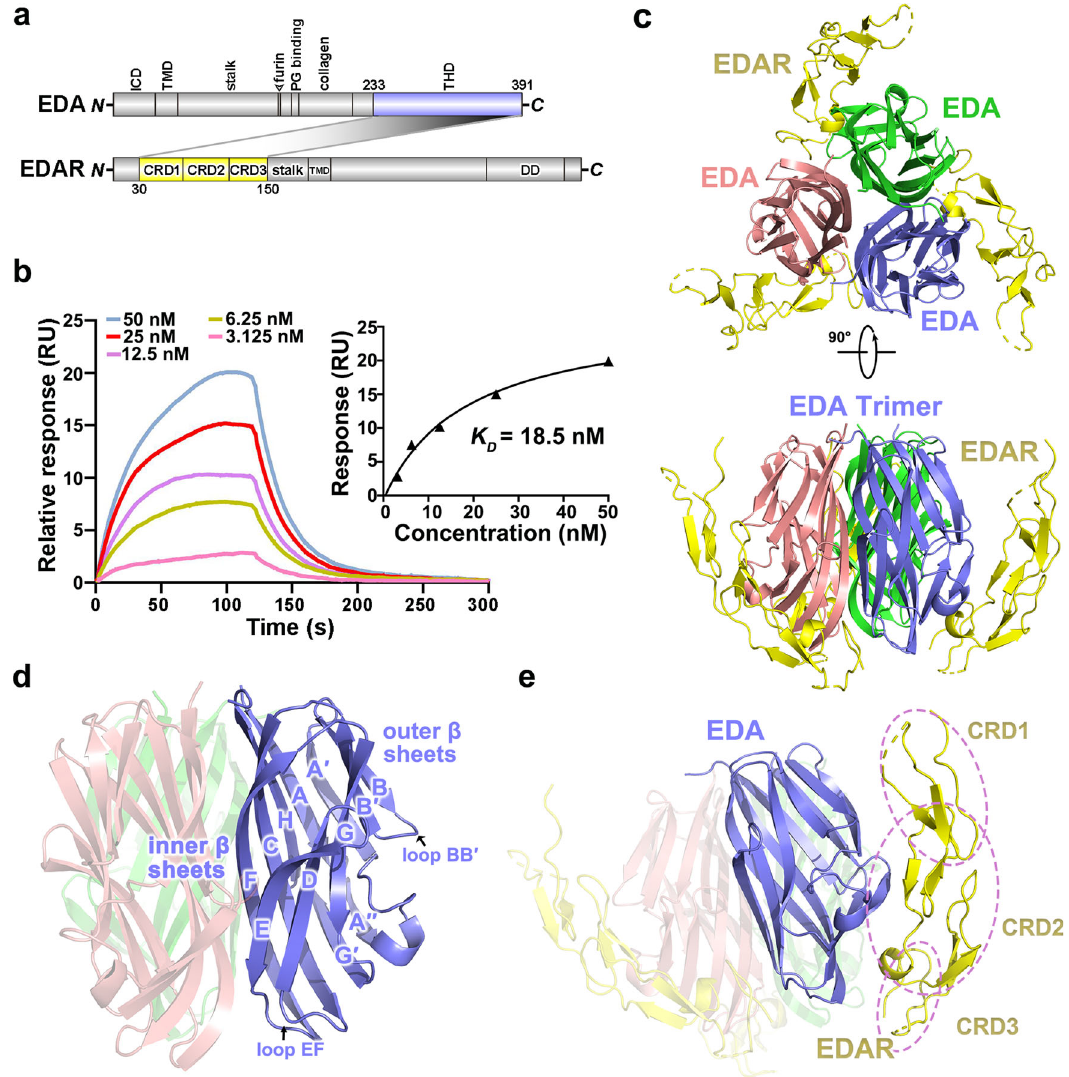
Fig. 1 | Overview of the EDA·A1 THD -EDAR CRDS complex structure. a Domain organization of EDA · A1 and EDAR. The interacting domains are labeled and high- lighted in different colors. The shaded areas indicate the interaction between EDA · A1 and EDAR. ICD intracellular domain, TMD transmembrane domain, THD TNF homology domain, CRD cysteine-rich domain, DD death domain. b Surface plasmon resonance measurements showing that WT EDA · A1 THD interacts with EDAR CRDS in a concentration-dependent manner. Graphs of equilibrium response unit versus EDA · A1 THD concentrations are plotted. The estimated K D for the